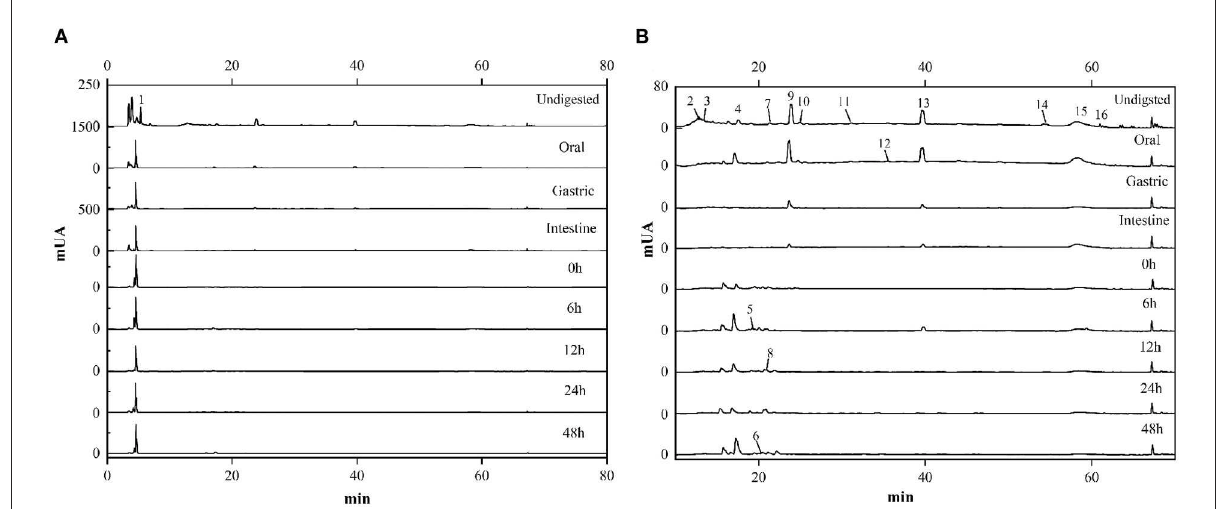
FIGURE5 HPLC chromatograms of FJR during in vitro simulated digestion and colonic fermentation. (A) Chromatogram at the larger ordinate (0-1500). (B) Chromatogram at the smaller ordinate